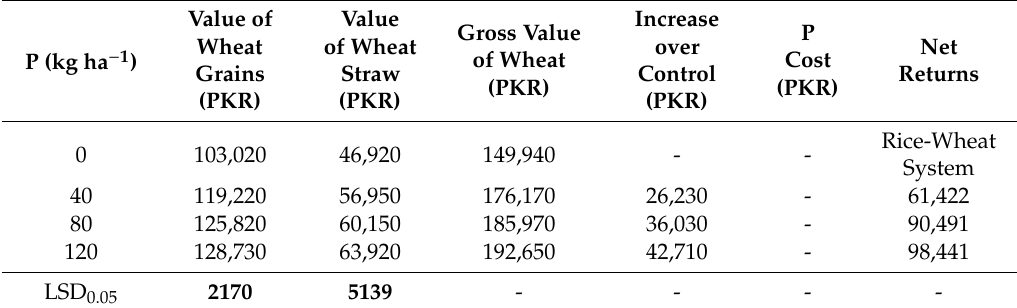
Table 3. Impact of residual soil phosphorus on the economic analysis of the subsequent wheat crop under rice-wheat cropping